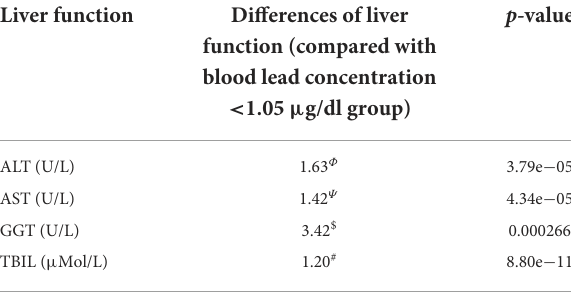
TABLE 3 Differences of liver function between high and low blood lead groups. Liver